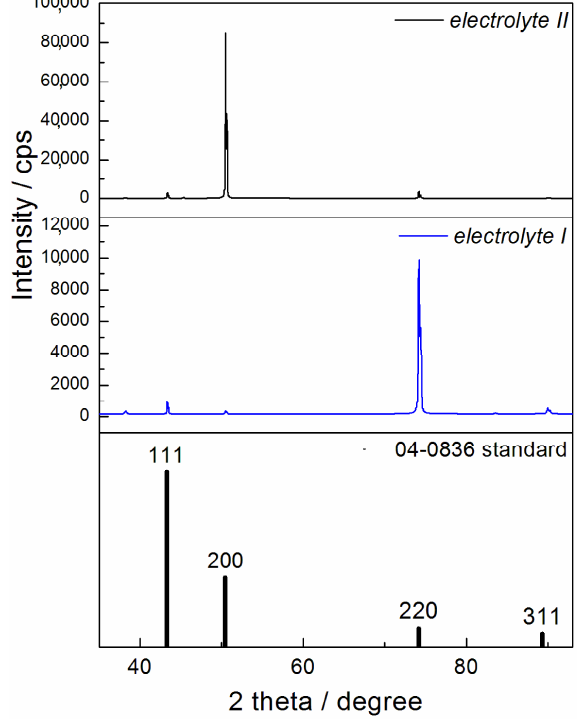
Figure 10. The XRD patterns of the 40 µm Cu coatings obtained from electrolytes without ( electro- lyte I ) and with additives ( electrolyte II ).